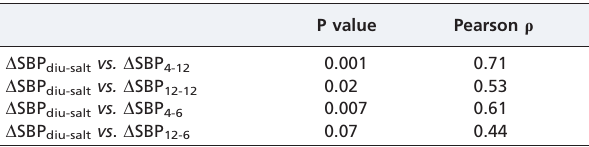
Table 3 - Pearson correlation coefficient ( r ) between the variation in CS D SBP diu-salt in a salt loading and depletion maneuver and the mean variation in SBP obtained by ABPM according to intervals of measurement (see text for details).